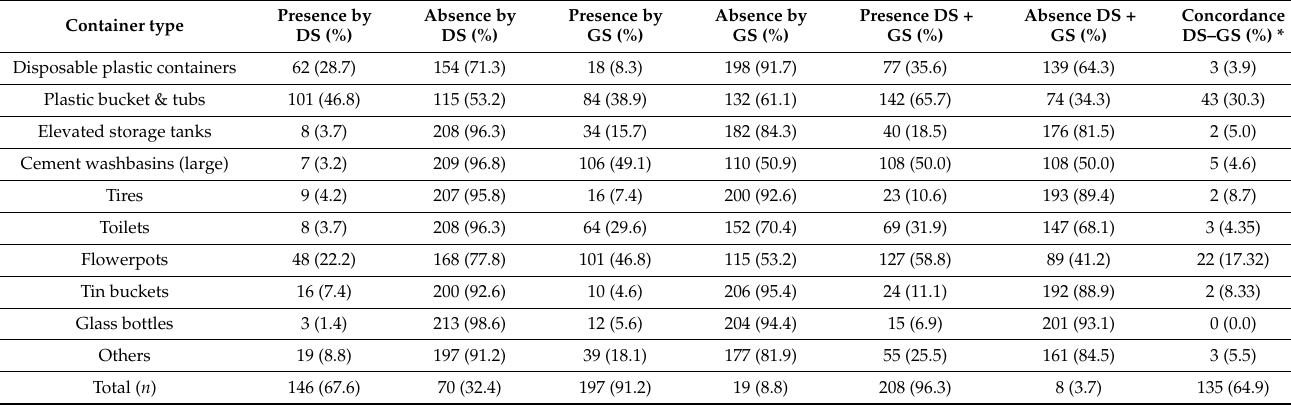
* Number and percentages of houses with at least one container detected by both DS and